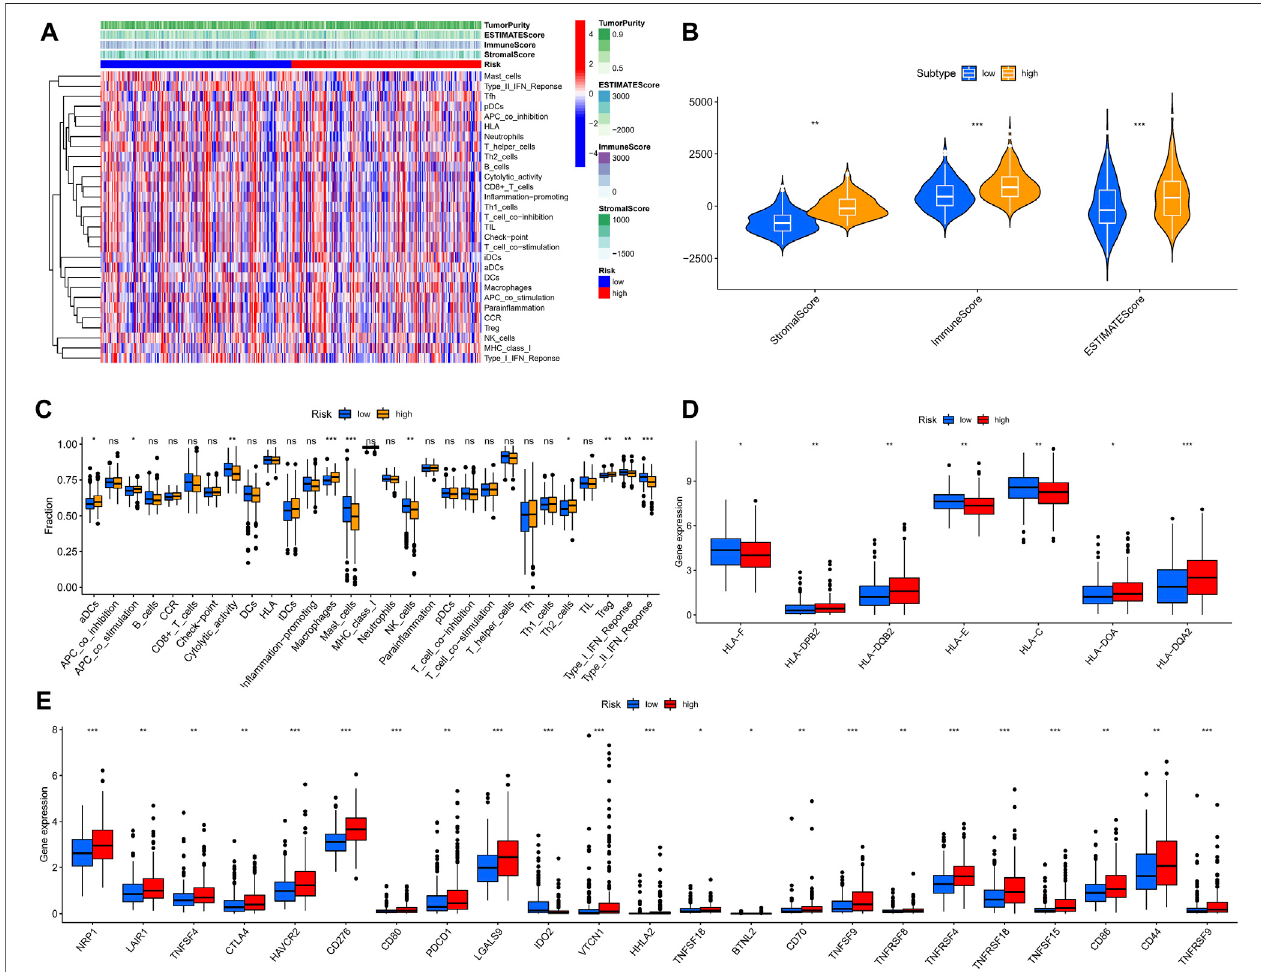
FIGURE 9 | Immune microenvironment analysis in different risk groups. (A,B) Stromal, immune, and estimate scores of patients with different risks. (C) The ssGSEA scores of immune cells and immune functions. (D) Expression of HLAs in different risk groups. (E) The comparison of immune checkpoints between high and low-risk groups. (ns, p > 0.05; *, p < 0.05; **, p < 0.01; ***, p < 0.001).